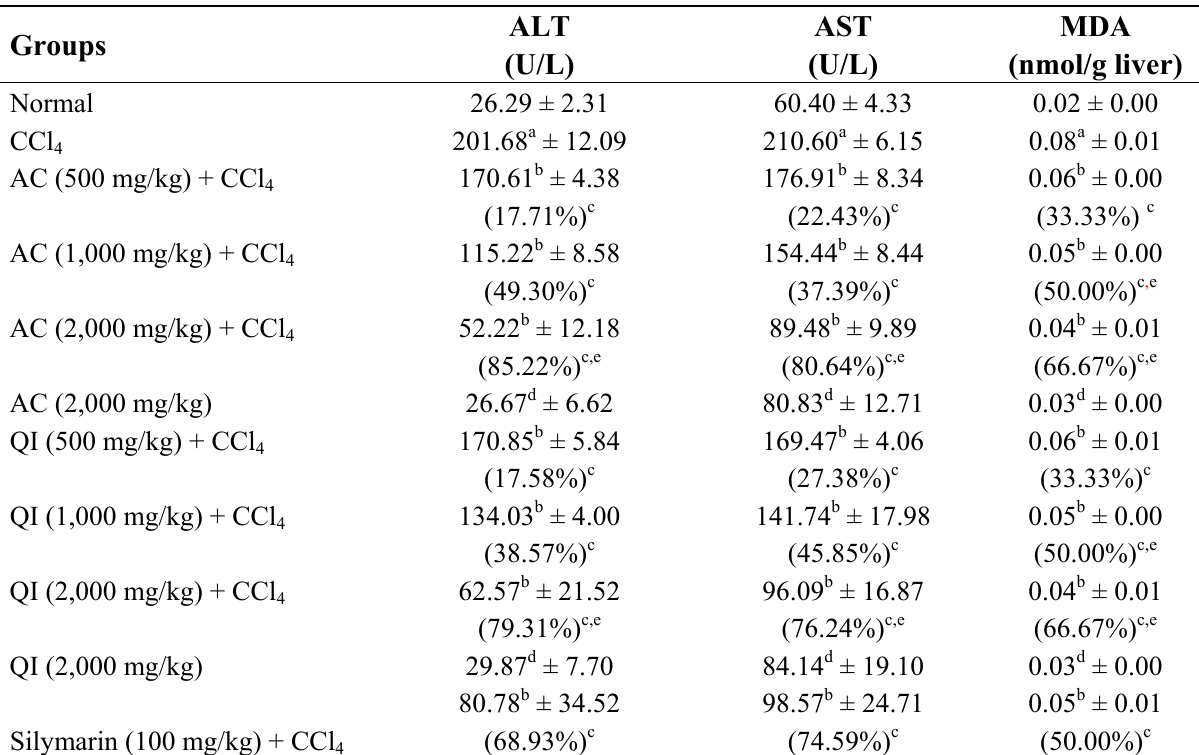
Table 2. Effect of AC and QI on serum ALT, AST and hepatic MDA in liver injury in rats. Values are mean ± SEM of five induced by CCl 4